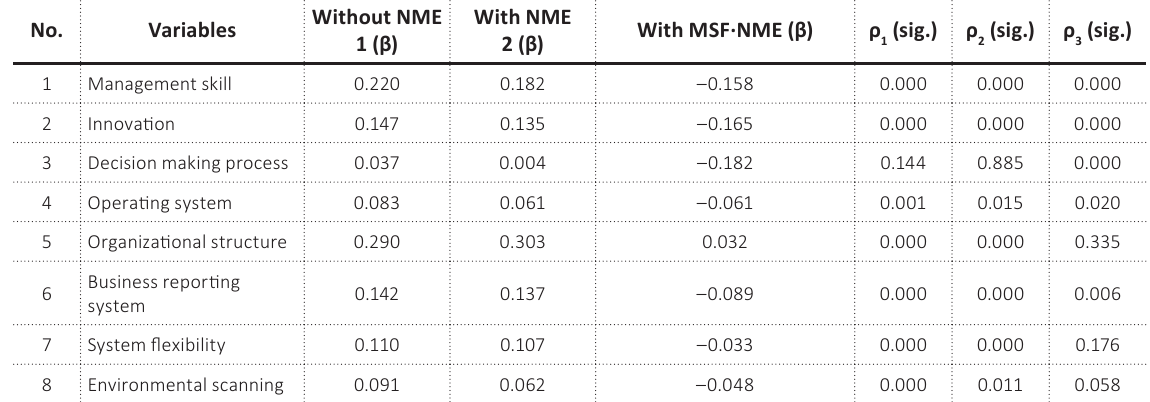
Source: Field survey results